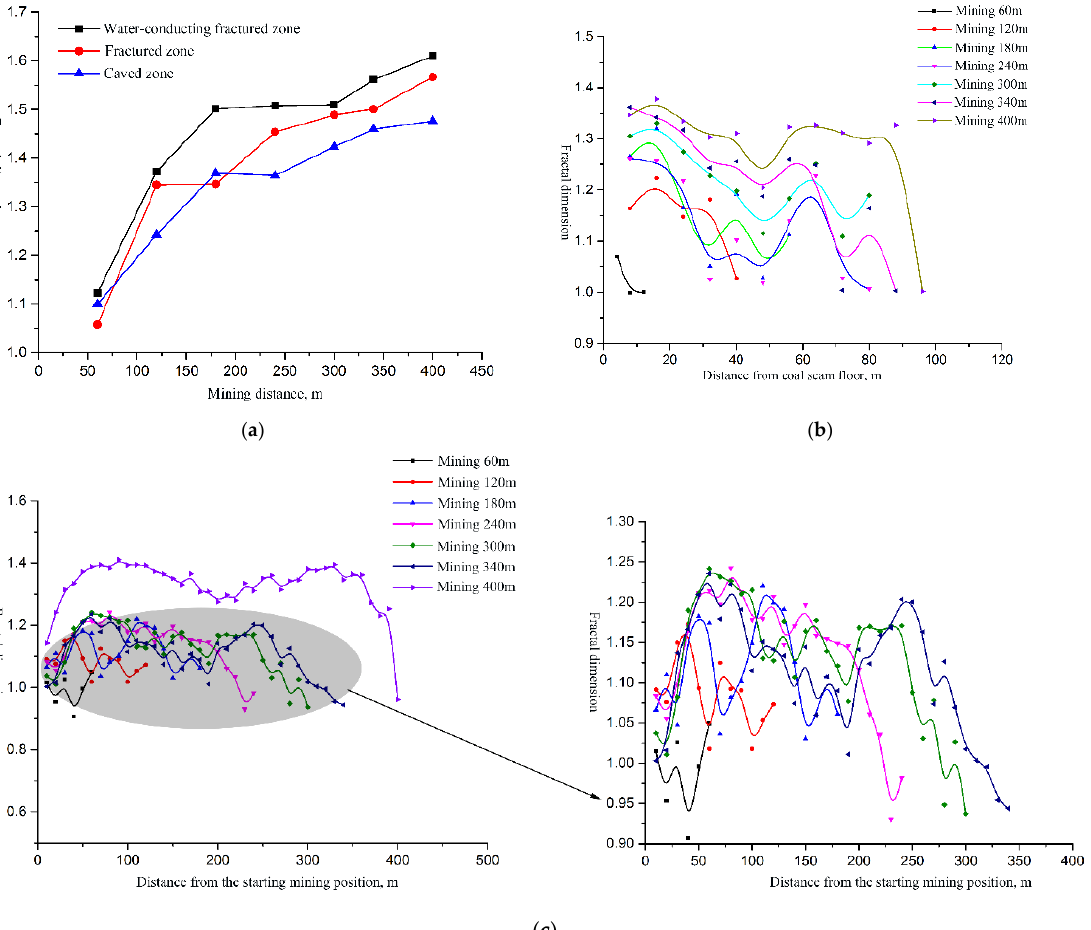
Figure 6. Spatio-temporal variation of fractal dimension of rock mass fractures: ( a ) due to mining; ( b ) in the vertical direction; and ( c ) in the mined direction. Stage I is when the fractal dimension of the rock mass fractures quickly increases.